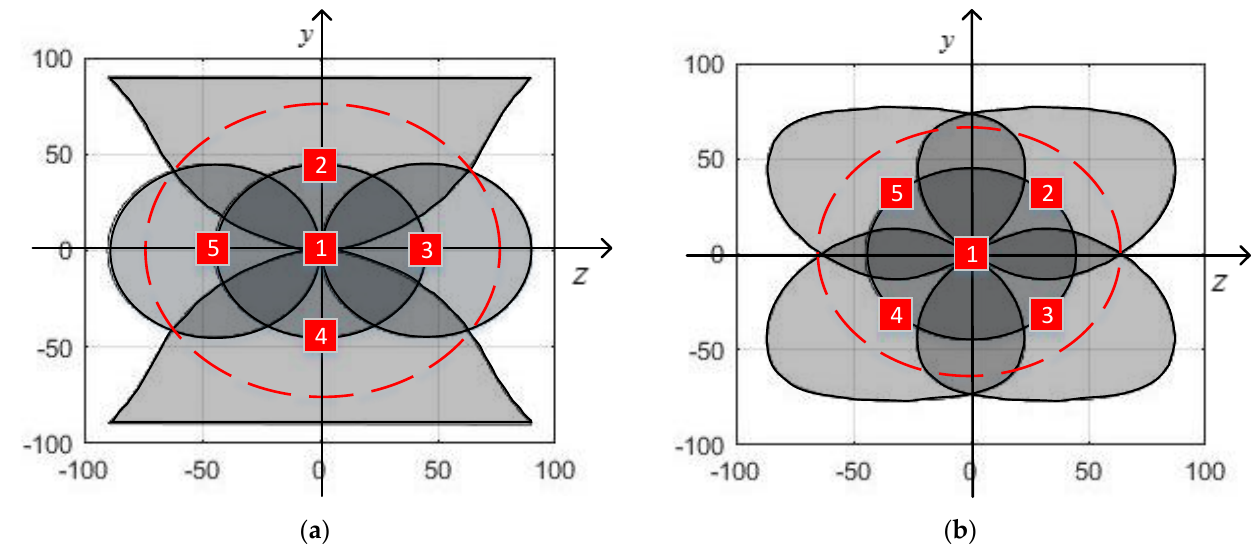
Figure 5. Circular FOV sensor array overlay diagrams. ( a ) +-shaped layout. ( b ) X-shaped layout.